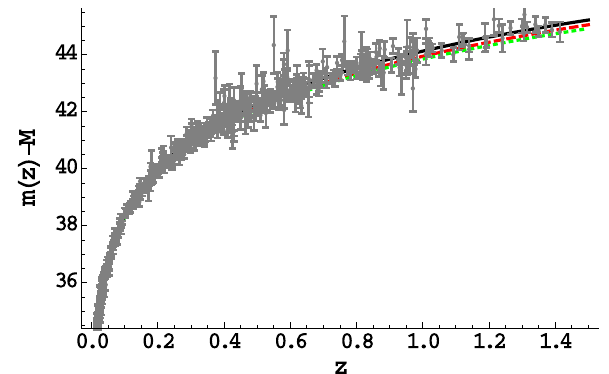
Fig. 4 The theoretically predicted apparent minus absolute magnitude as a function of the redshift, for the scenario of modified cosmology through nonextensive thermodynamics, for (cid:3) = 0, in the case where radiation is present, for δ = 0 . 5 (red-dashed) and δ = 0 . 6 (green- dotted). The observational points correspond to the 580 SN Ia data points from [58], and for completeness and comparison we depict the prediction of (cid:3) CDM cosmology with the black-solid